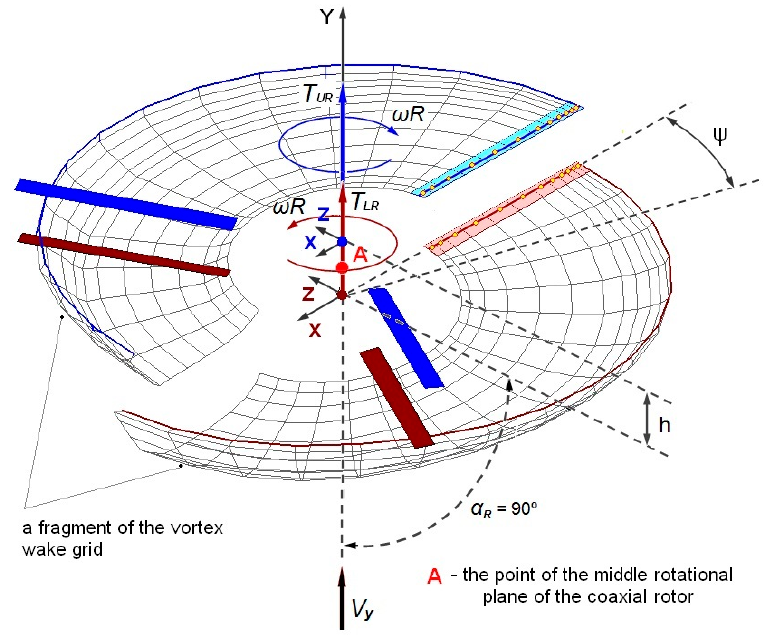
Figure 2. Calculation model of the coaxial rotor under study.